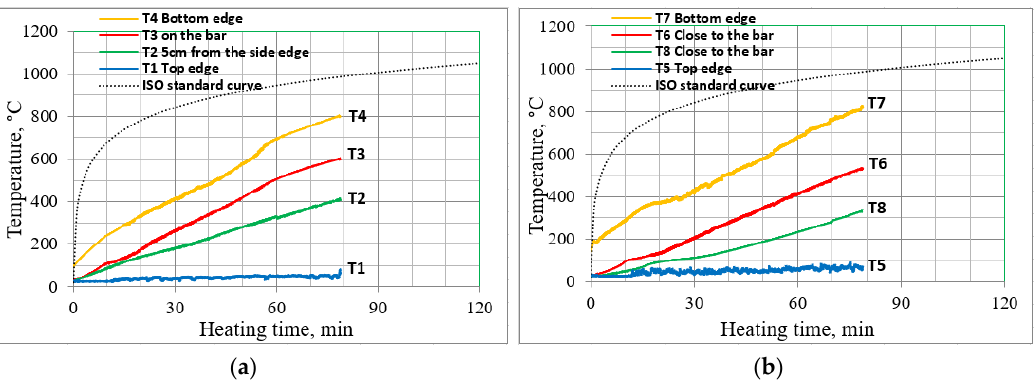
Figure 7. Measurements from the thermocouples embedded in the sample B2Ø14; ( a ) location A; ( b ) location B and C.